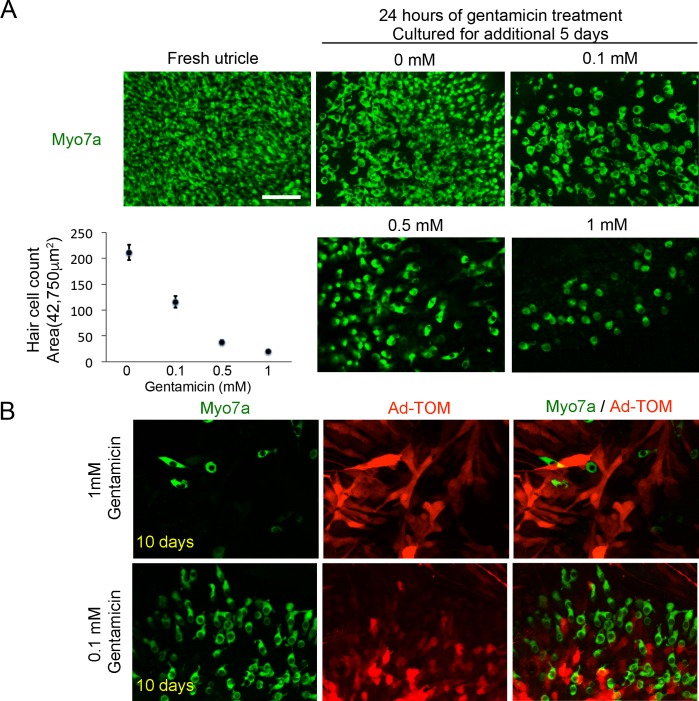
Ad-tdTomato specifically labels supporting cells after gentamicin killing.(A) Myo7a staining in freshly dissected adult utricle explants, and explants treated with different concentrations of gentamicin for 24 hr and cultured for a further 5 days. Hair cell counts per unit area are shown for each concentration. Scale bar, 50 µm. (B) Immunofluorescence staining for Myo7a and TdTomato antibodies of utricle explants treated with 1 mM or 0.1 mM of gentamicin for 24 hr and then infected with Ad-tdTomato for 24 hr and cultured for another nine days. Supporting cell morphology is abnormal and elongated in cultures treated with 1 mM gentamicin and normal in cultures treated with 0.1 mM gentamicin. Scale bar, 50 µm.